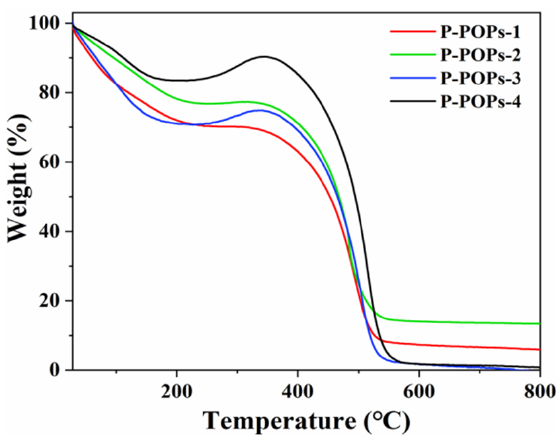
Figure 2. Thermogravimetric analysis of P-POPs under air.